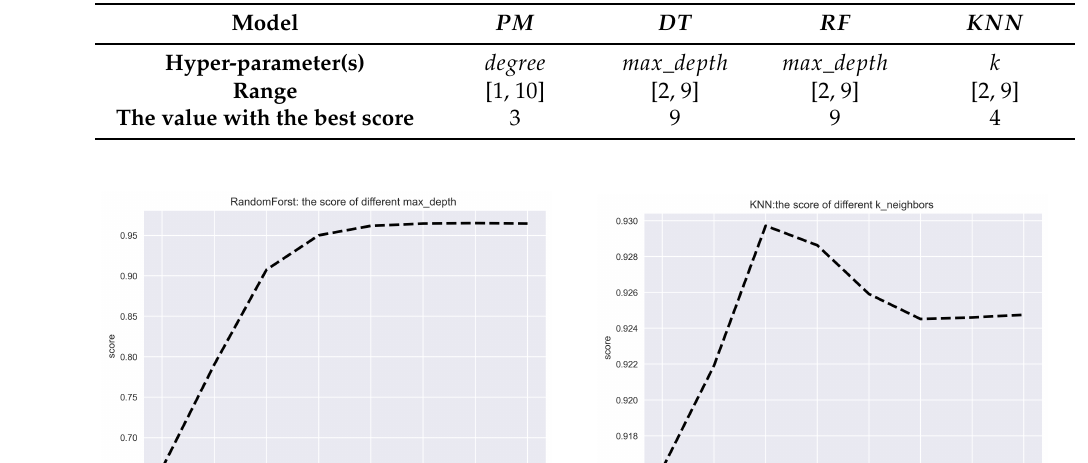
Table 4. The hyper-parameters tuning when training PM, DT, RF and KNN.